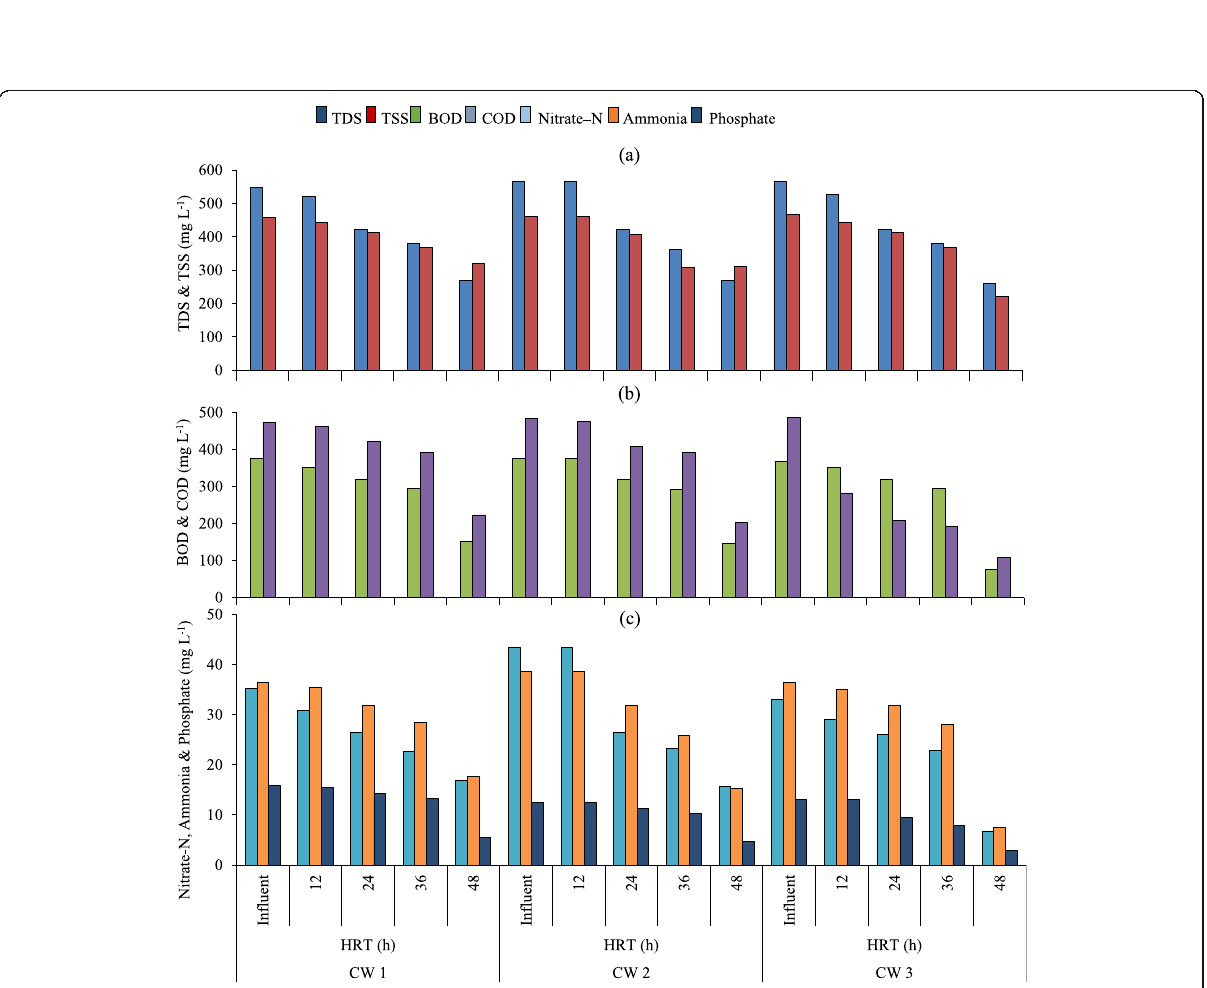
Fig. 3 Variation in physicochemical properties (TDS, TSS, BOD, COD, Nitrate-N, Ammonia, & Phosphate) of primary treated sewage through different set of constructed wetlands as a function of